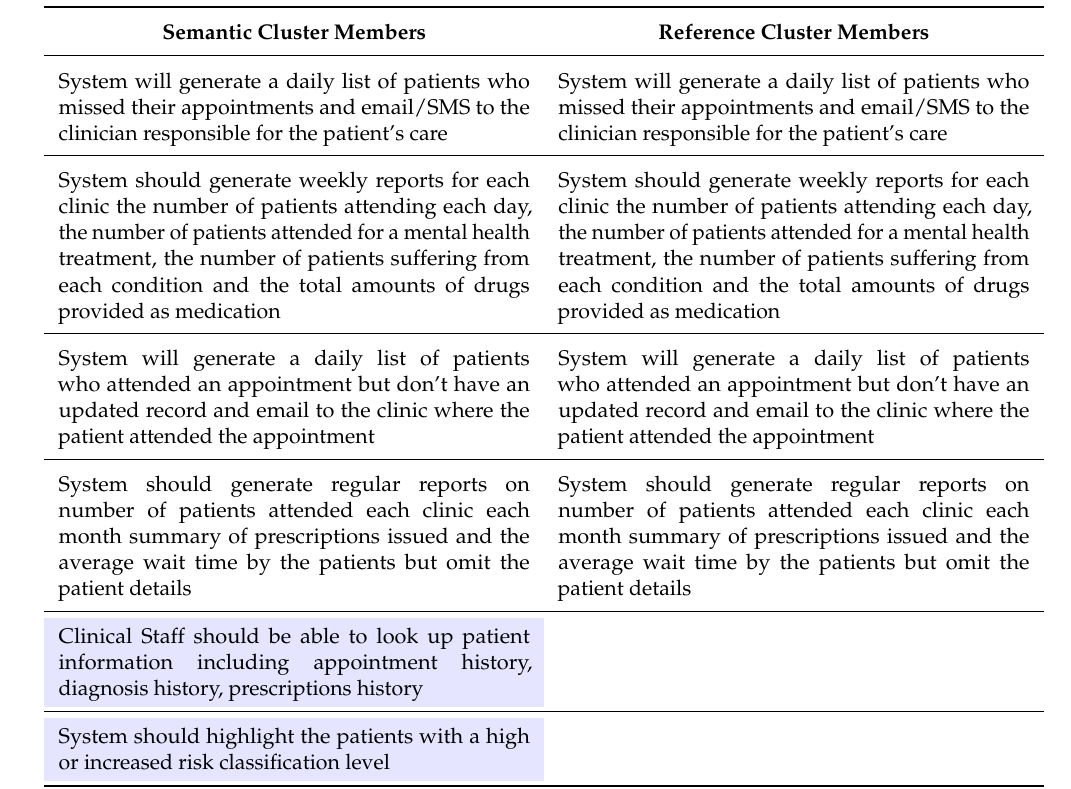
Table 9. An example of a semantic cluster identified from MHC-PM